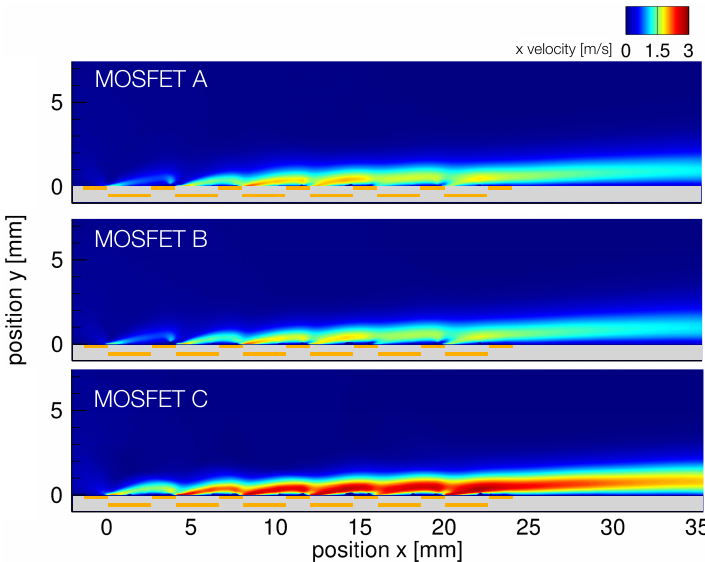
Figure 5. Time-averaged spatial distributions of the x -component of the velocity induced by a DBD plasma actuator with different SiC-MOSFETs.